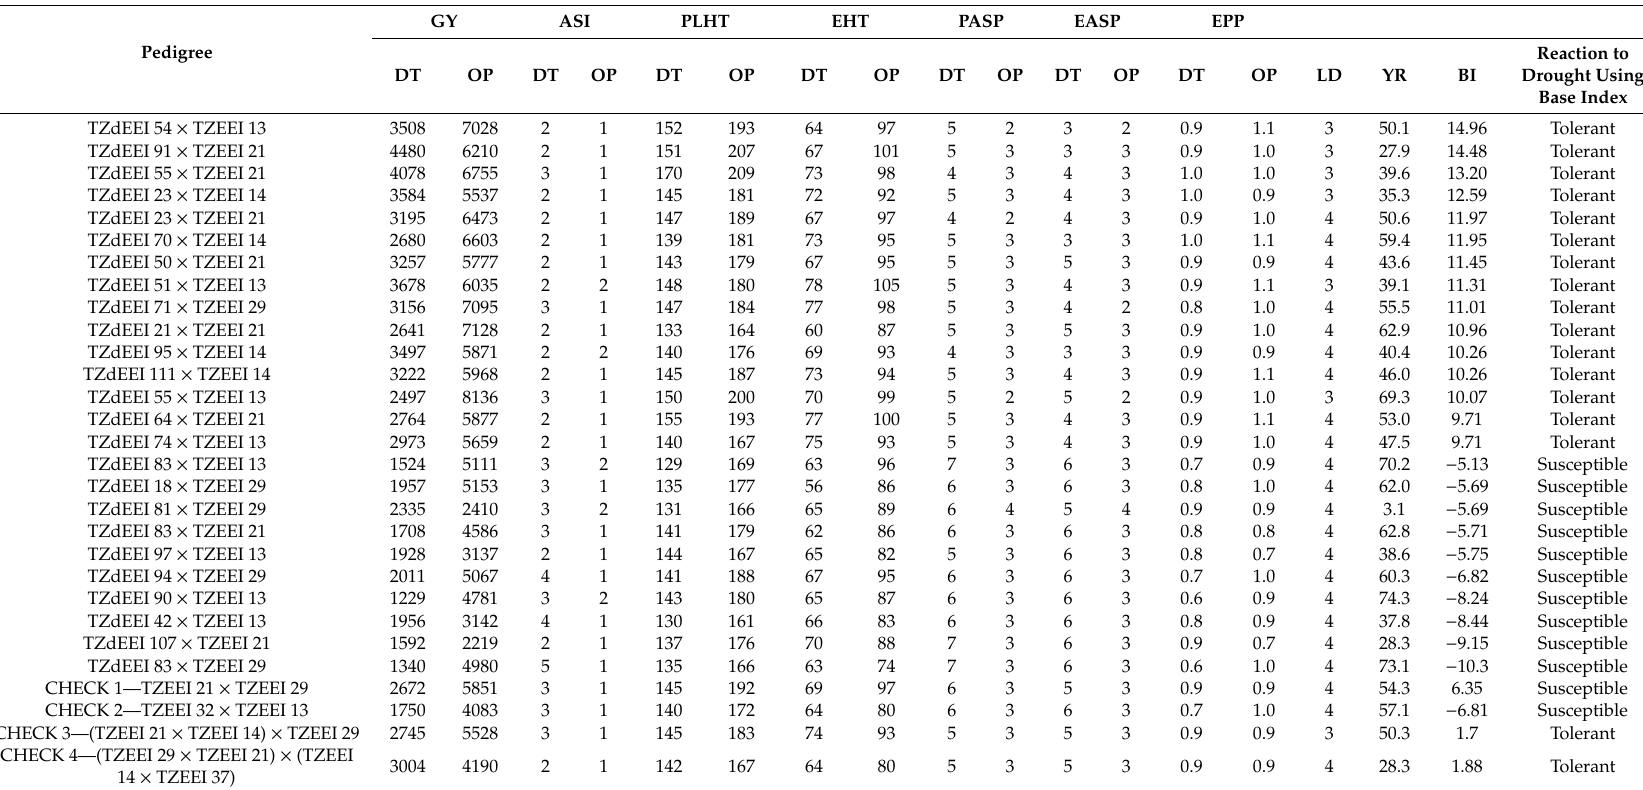
Table 2. Grain yield and other agronomic traits of hybrids (the best 15 and the worst 10 based on the base index) and hybrid checks evaluated under drought (DT) and optimal (OP) environments in Nigeria between 2013 and